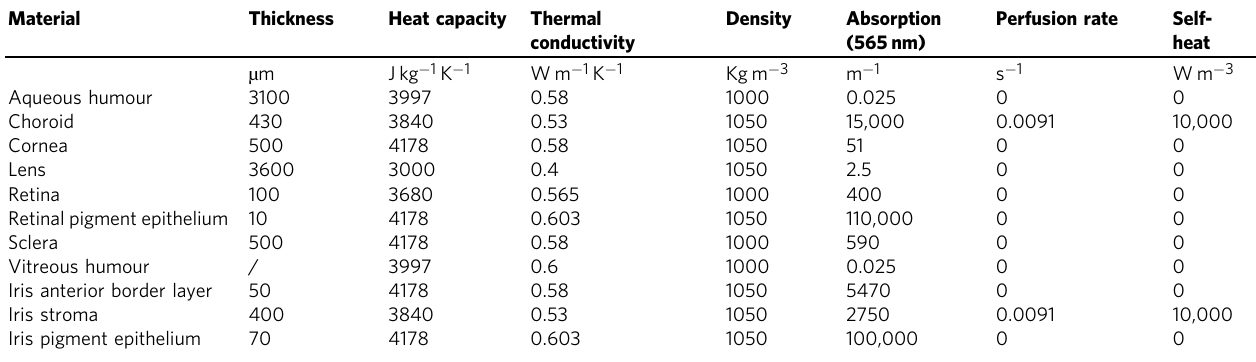
Table 2 Eye parameters used for the eye